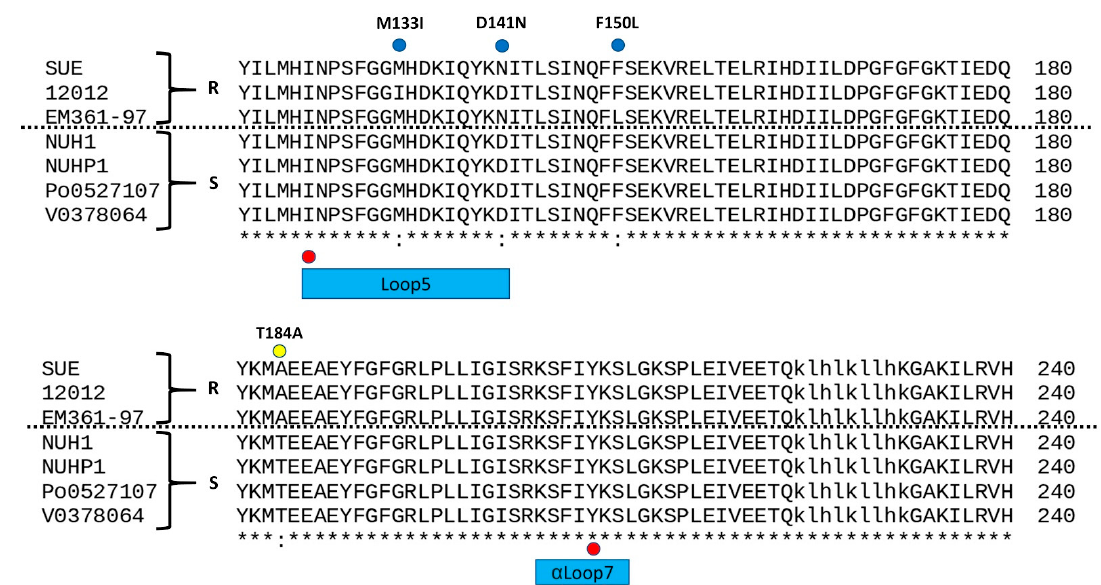
Figure 1. Sequence alignment of seven E anopheles DHPS orthologs. Residues marked in red dots are loci of known sulfa resistance mutations, and blue/yellow dots indicate those residues mutated in the current study. Loop1, loop2, loop5, and helix α Loop7 are boxed in bars with different colors.